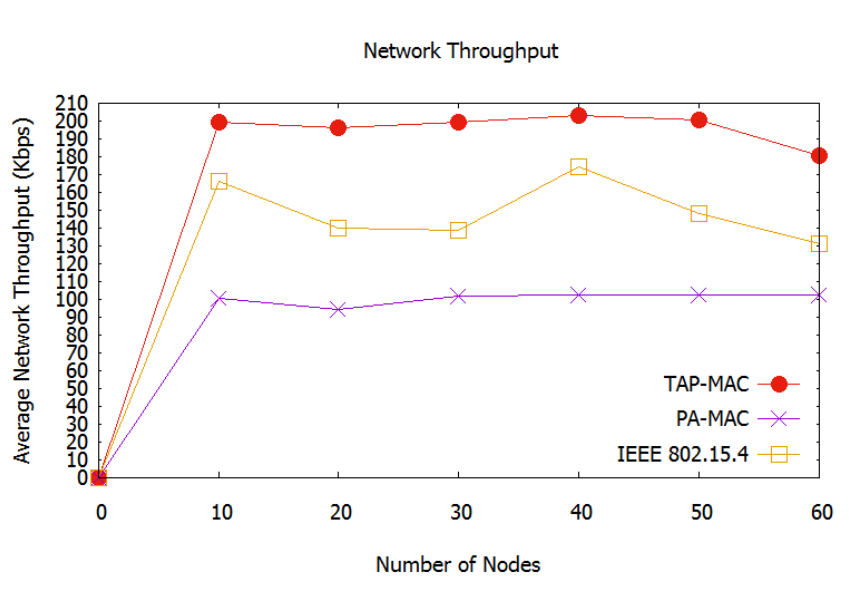
Figure 14. Scenario 3: Average network throughput.